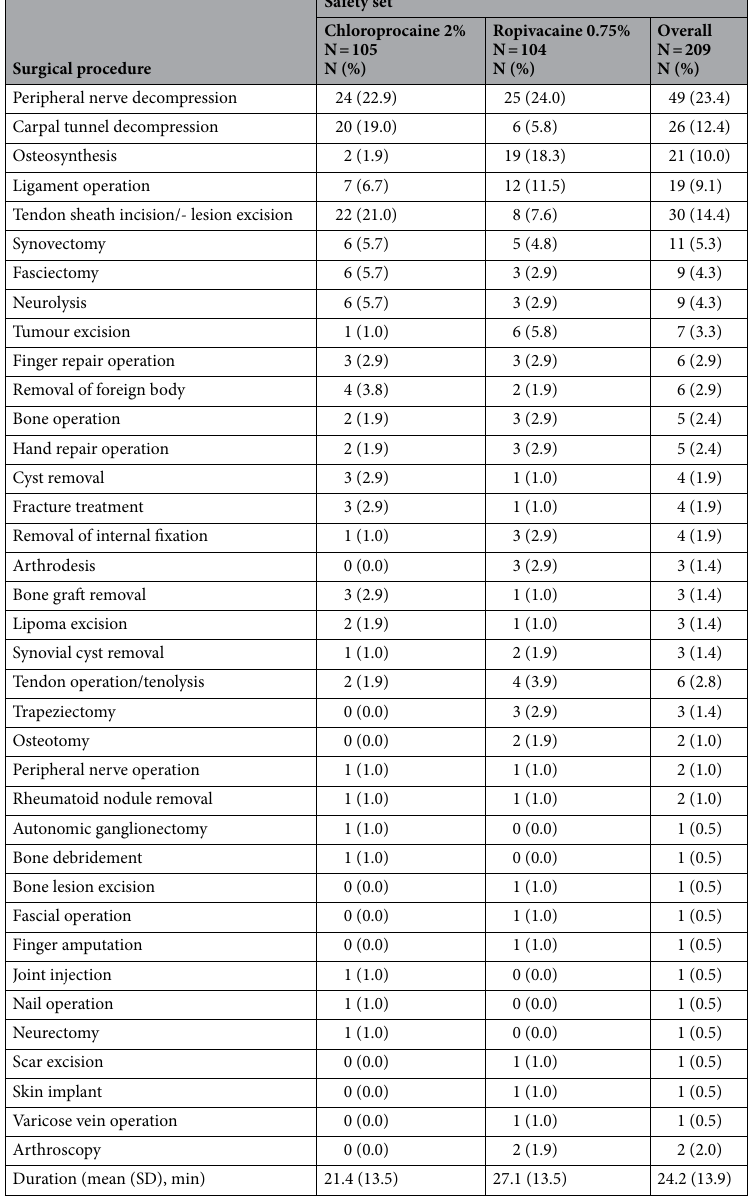
Table 2. Surgery data.